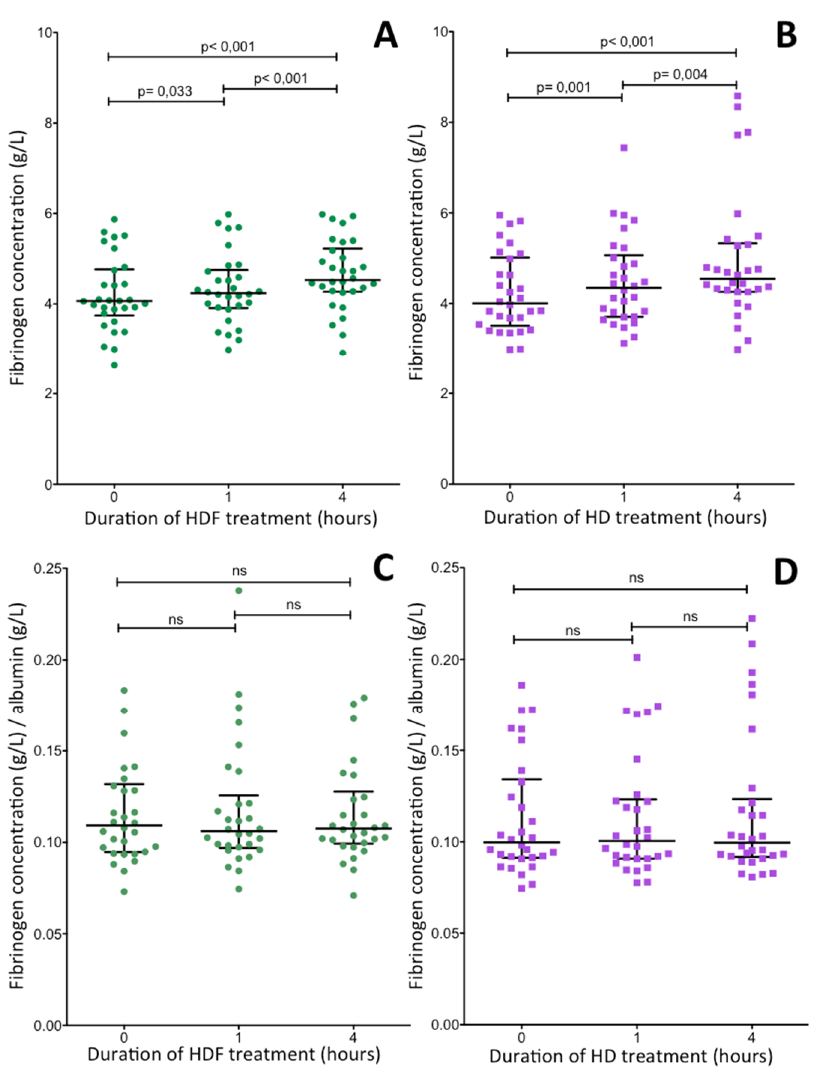
Figure 4. Changes of plasma fibrinogen concentration in ESRD patients during a 4-h HDF ( A , C ) or HD ( B , D ) treatment. The two upper figures demonstrate fibrinogen concentrations not corrected for albumin ( A , B ), while the two lower figures show fibrinogen concentrations corrected for albumin ( C , D ). Long and short horizontal lines in the figures represent median values and limits of interquartile ranges, respectively. Significant differences between results obtained before and after treatments are indicated by the p values above thin horizontal lines.